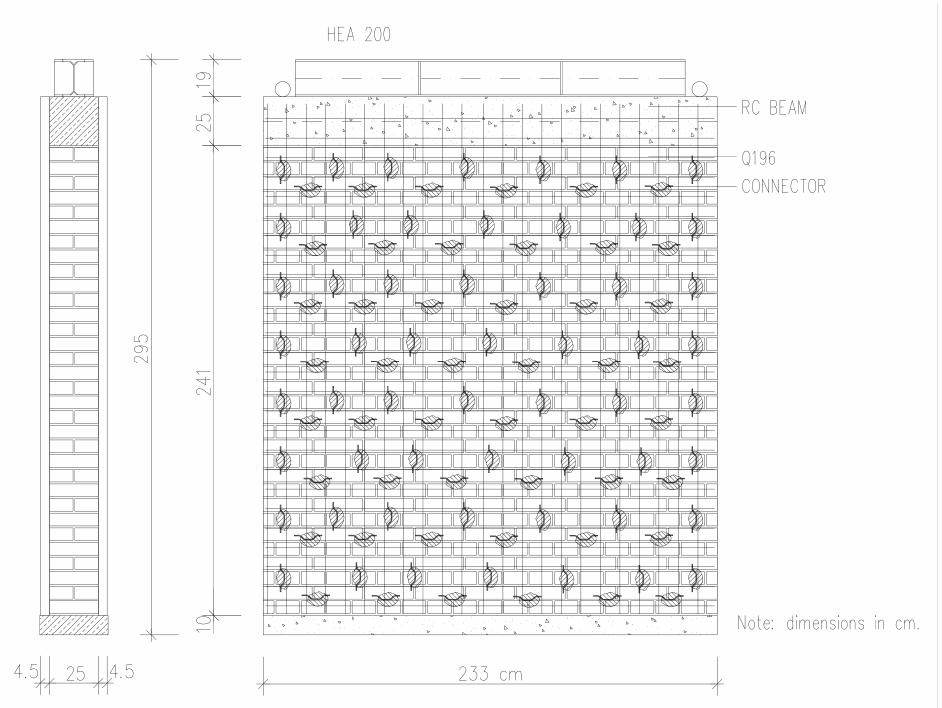
Figure 5. Distribution of anchors and geometry of the strengthened wall—strengthening Type II.